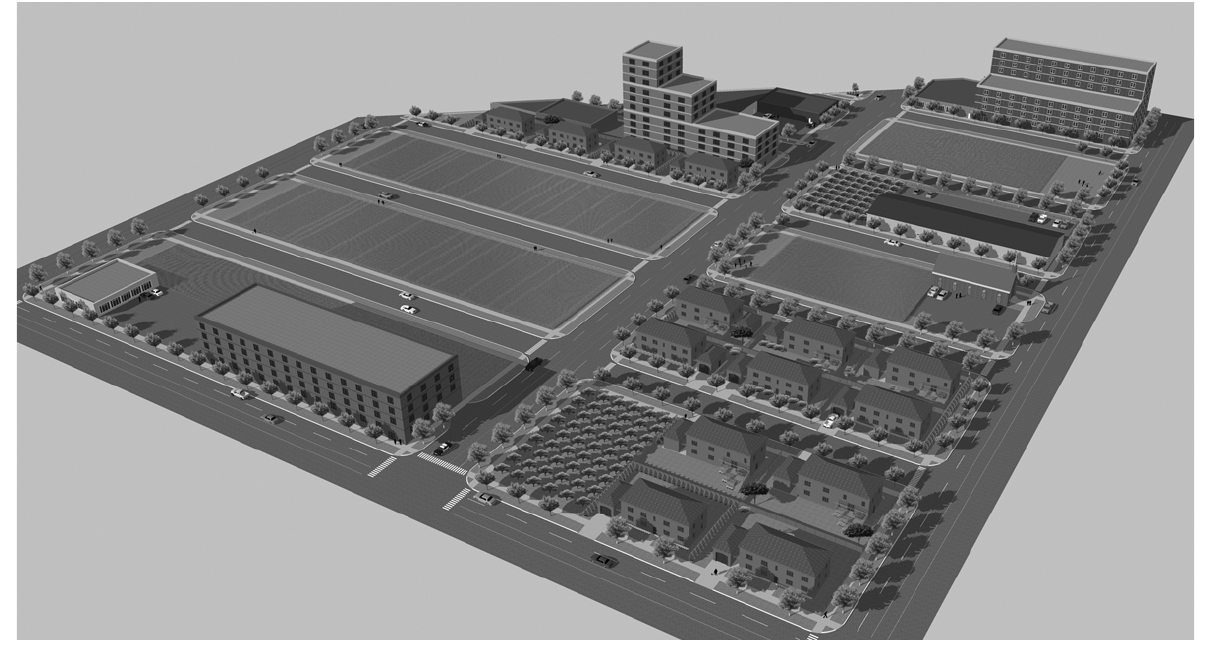
Figure 4. A digital model featuring some of the ideas affiliated with the new vision for Detroit. (© 2011 Shawn Partin, all rights reserved, used by